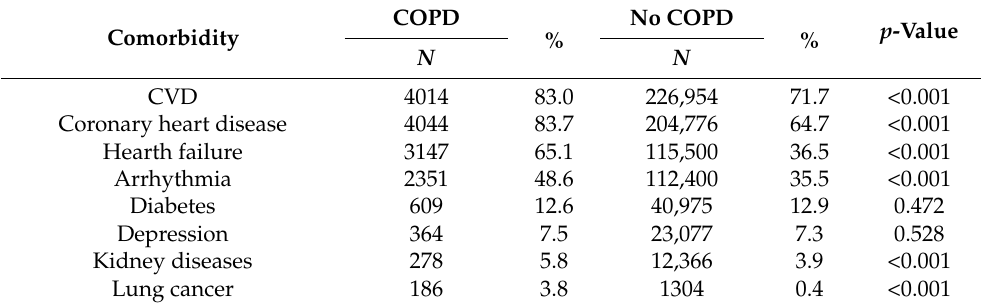
Table 2. Prevalence of other comorbidities in COPD patients.